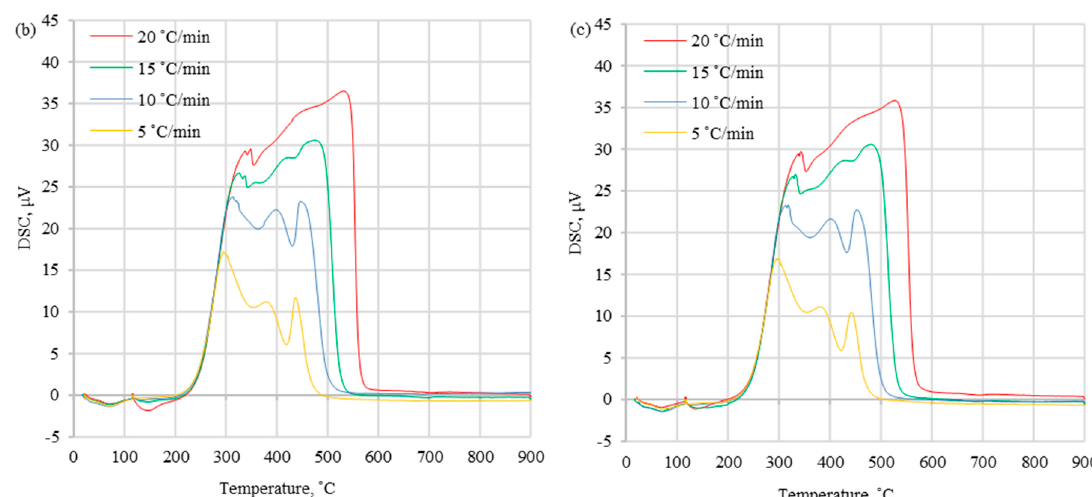
Figure 6. DSC curves for ( a ) WS, ( b ) DS0, and ( c ) DS4 at different heating rates. Murredu et al. [16] calculated the combustibility indices including the ignition index Table 3. Main combustion parameters. (D i ), the burnout index (D f ), and combustion indices S and H f . The research was conducted for coal and biomass samples under atmospheric air and pure oxygen atmosphere. When the investigated samples were compared, the obtained D i , D f , and S indices for biomass had a value by an order of magnitude higher than for coal. Authors in article [16] observed that biomass samples were characterized by a better ignition performance than coal samples, which was verified with the combustion index D i . D i for coal samples under the air atmo- sphere was in the range of 8.5–7.0 × 10 − 3 wt%/(min 3 ) and for biomass samples was in the range of 36.1–40.0 × 10 − 3 wt%/(min 3 ). A similar observation was proven for D f index in the experiments conducted in air atmosphere treatment, where significantly smaller D f values were determined for coal samples D f < 2 × 10 − 5 wt%/(min − 4 ) compared to biomass sam- ples 43.4–53.5 × 10 − 5 wt%/(min − 4 )). S index was less than 9.7 × 10 − 8 wt%/((min − 2 · ◦ C − 3 )) for coal samples and was in the range of 73.7–84.9 × 10 − 8 wt%/((min − 2 · ◦ C − 3 )) for biomass samples (under air atmosphere treatment). An opposite to D i , D f and S indices observation was for H f index (H f value was lower for biomass than for coal samples). In the case of combustion, for all samples, the determined H f value was lower than 2.4 × 10 3 ◦ C (coal samples: 2.0–2.4 × 10 3 ◦ C, biomass samples: 0.3 × 10 3 ◦ C). This confirmed the correctness of the results obtained by the authors of this article (Table 3) by showing a similar order of magnitude of the value and the same tendency for raw biomass